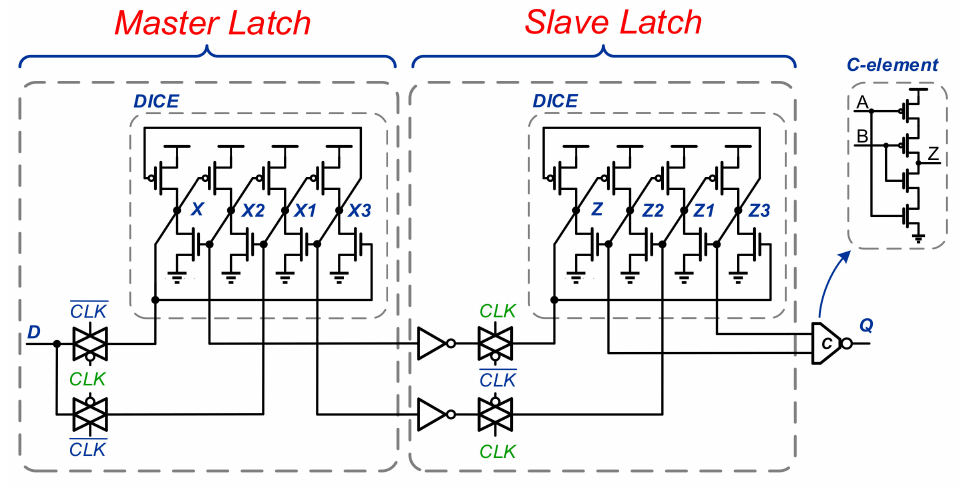
Figure 4. Schematic diagram of DICE-DICE.